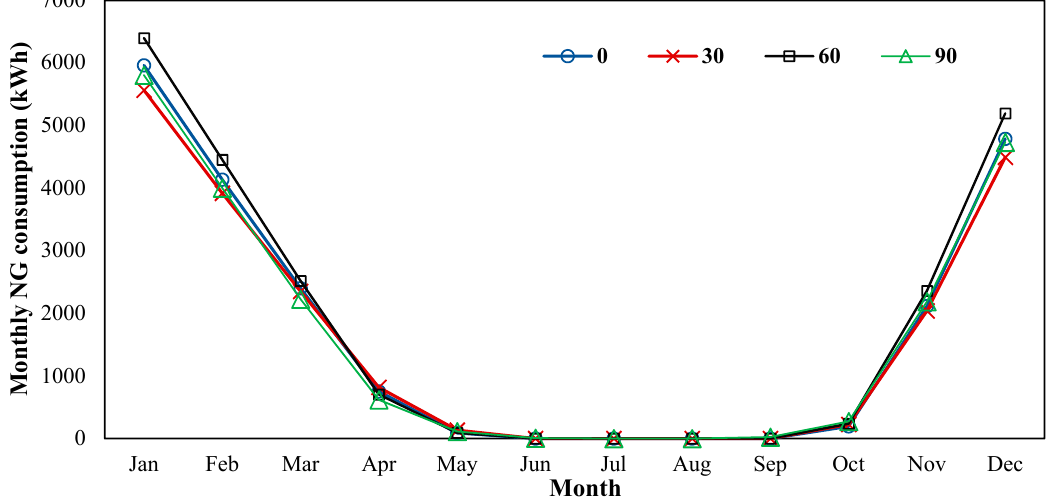
Figure 7. Monthly natural gas consumption for different building orientations (°).